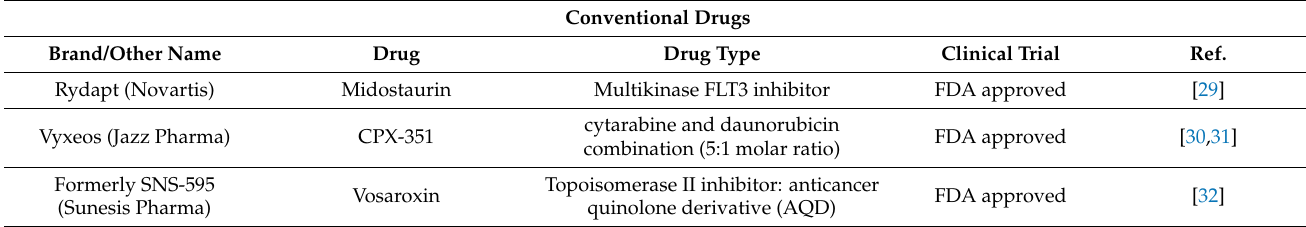
Table 1. Therapeutic drug for acute myeloid